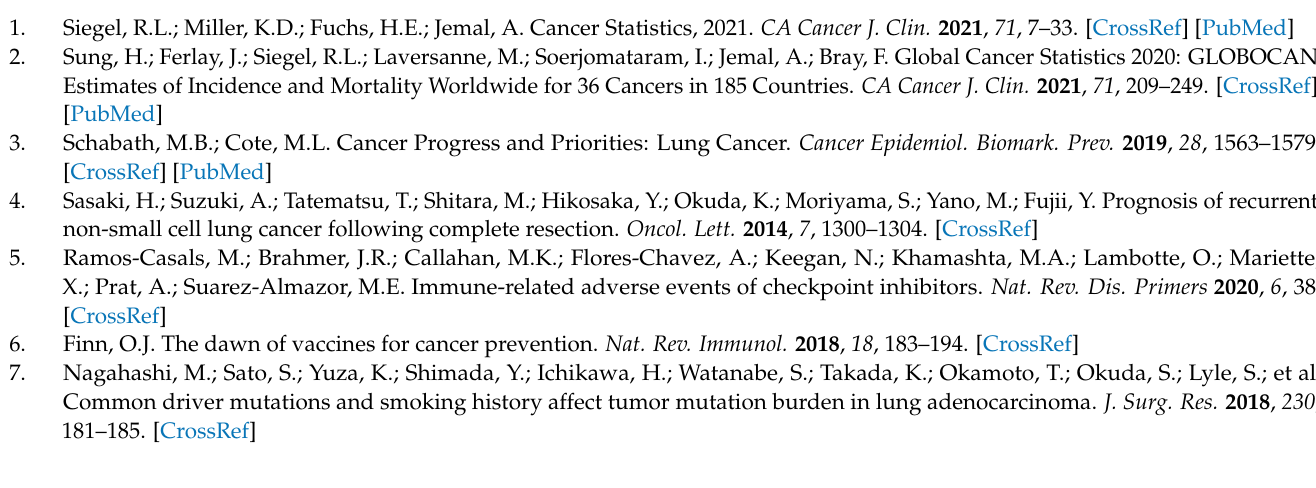
Figure S2: Lymphoid aggregate numbers in mice lacking Kras G12D oncogene, Figure S3: CD4 + T cell depletion platform and the efficacy of long-term CD4 + T cell depletion in mice, Table S1: Antibodies used in the